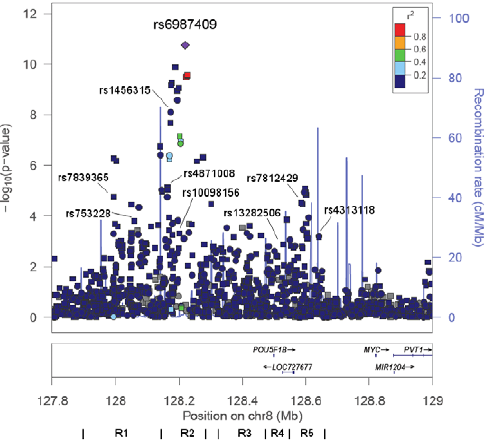
Figure 3. 2 Log P Plot for Common Alleles at 8q24 in African Americans. 2 Log P-values for alleles in the region 127.8–129.0 Mb in African Americans from logistic regression models adjusted for age, study, global ancestry (the 1 st 10 eigenvectors) and local ancestry. Pairwise correlations in the HapMap YRI population are shown in relation to rs6987404, which was the most significant marker in the region (p=1.8 6 10 2 11 ). Circles are genotyped SNPs and squares are imputed SNPs. Grey circles are SNPs not in HapMap (r 2 can not be estimated). The lines below demarcate the five risk regions (R) as defined in [1,2,7,10,13]. The plot was generate using LocusZoom [45]. The nine SNPs highlighted are from the stepwise analysis presented in Table